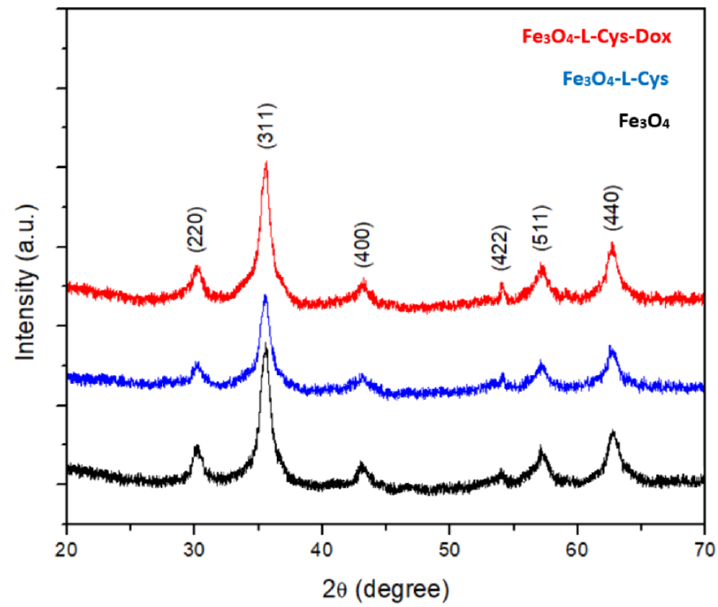
Figure 2. XRD patterns of Fe 3 O 4 , Fe 3 O 4 -L-Cys and Fe 3 O 4 -L-Cys-Dox NPs. The XPS results of Fe 3 O 4 -L-Cys can be visualized in Figure 3. The survey spectrum (Figure 3a) of the L-Cys functionalized NPs shows the presence of the specific elements: O, C, S, Fe and N. In Figure 3b, the high-resolution spectrum of Fe 2p is represented. The binding energy at 710.4 eV corresponds to Fe 2+ (Fe 2p 3/2) [41,42], whereas the peak at 711.4 eV is assigned to Fe 3+ (Fe 2p 3/2) [42,43] from the magnetite structure. The peaks at ~286 and ~288.5 eV from the C 1 s and O 1 s [42,44] spectra correspond to C-O and C = O bonds, and confirm the presence of L-Cys on the surface of the NPs. The XPS results prove that the surface of the NPs is functionalized with L-Cys, used further to bind